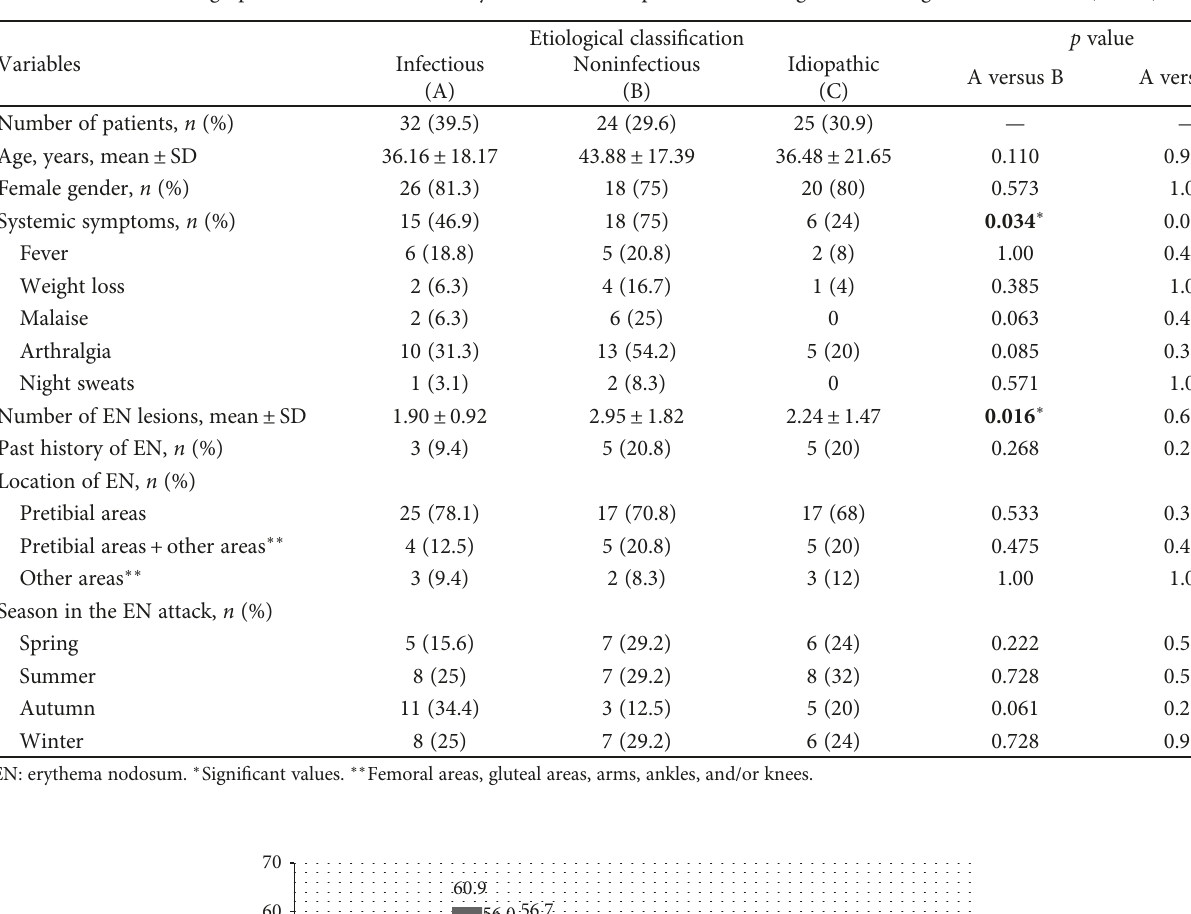
Table 4: Demographic and clinical data of erythema nodosum patients according to the etiological classi fi cation ( n = 81 ).